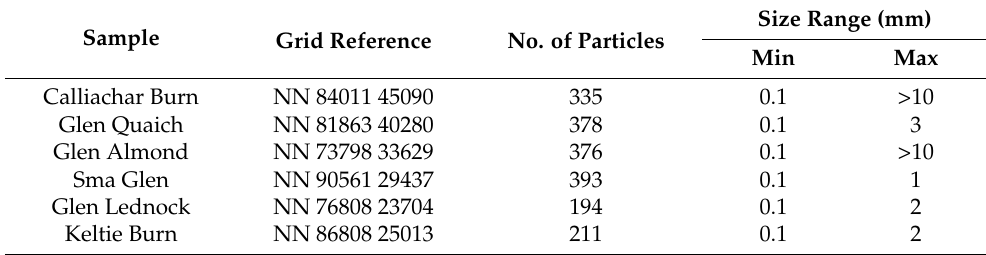
Table 1. Sample locations and sample